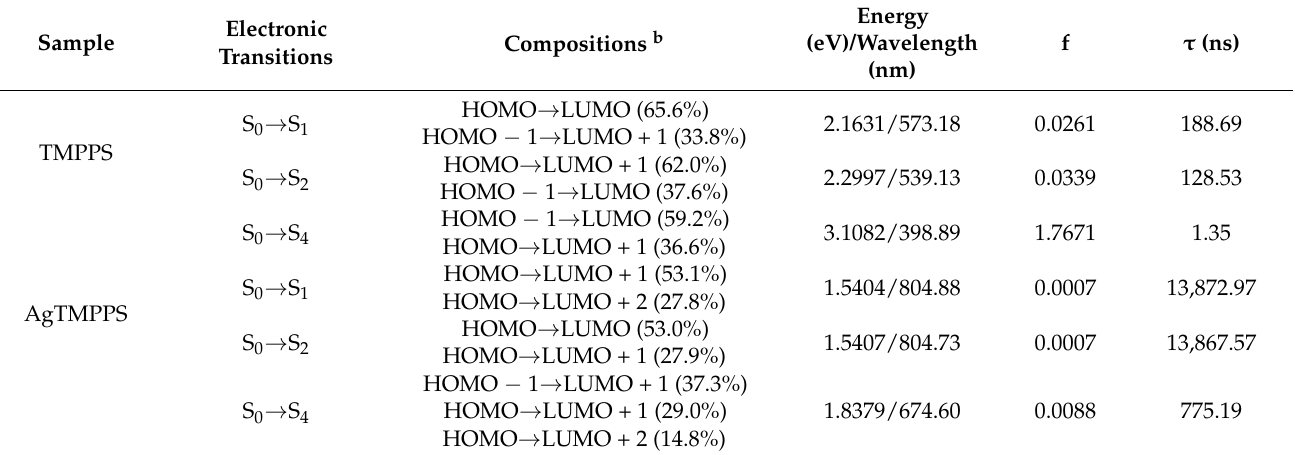
Table 1. Main electronic transitions, compositions of the low-lying electronically excited states, electronic excitation energies (eV), oscillator strengths (f), and the calculated possible fluorescence lifetimes ( τ ) of TMPPS and AgTMPPS a